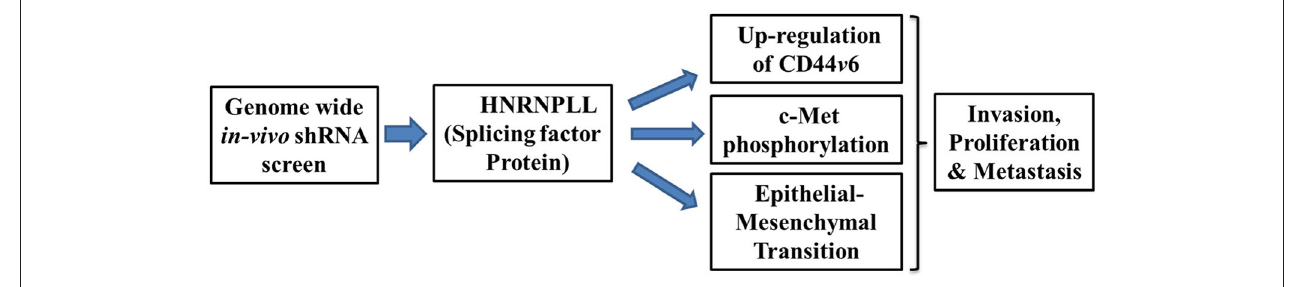
FIGURE 1 | Schematic illustration showing mechanisms of metastatic suppressor function of HNRNPLL. Silencing of HNRNPLL promotes alternate splicing of CD44 v 6 by exon inclusion, c-Met phosphorylation and epithelial-mesenchymal transition to regulates invasion, proliferation and metastasis in colon